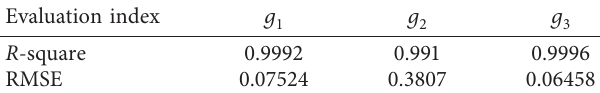
Figure 6: HR growth rate piecewise cubic spline interpolation function model. (a) Piecewise cubic spline interpolation function. (b) fitting. (c) Function g fitting. (d) Function g fitting. Function g 1 2 3 Table 6: Evaluation index of the driver’s HR growth rate fitting model in tunnel